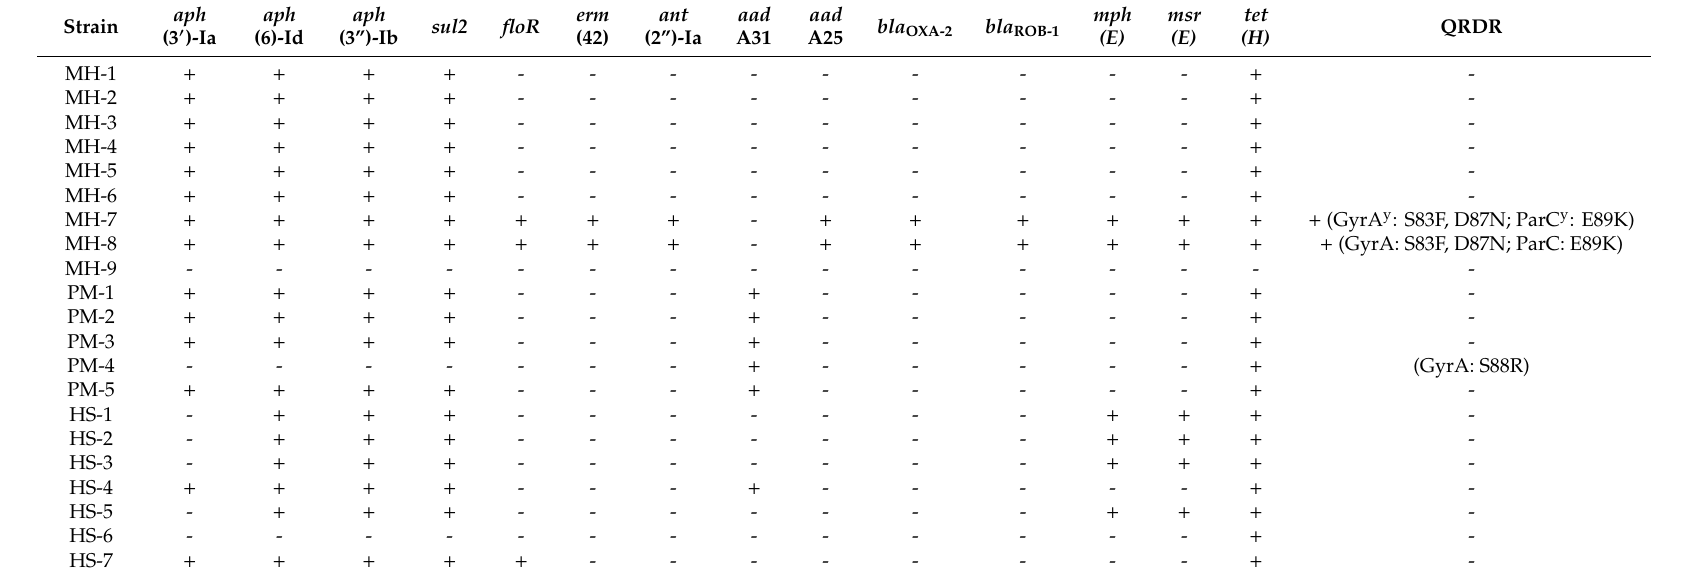
Table 9. Isolates of M. haemolytica , (MH), P. multocida (PM) and H. somni (HS) and antimicrobial resistance genes detected ( + ) or absent (-) by whole-genome sequence analyses (WGS). Genes with yellow shading were evaluated only by WGS. For genes with grey shading, PCR lacks concordance with WGS analyses.